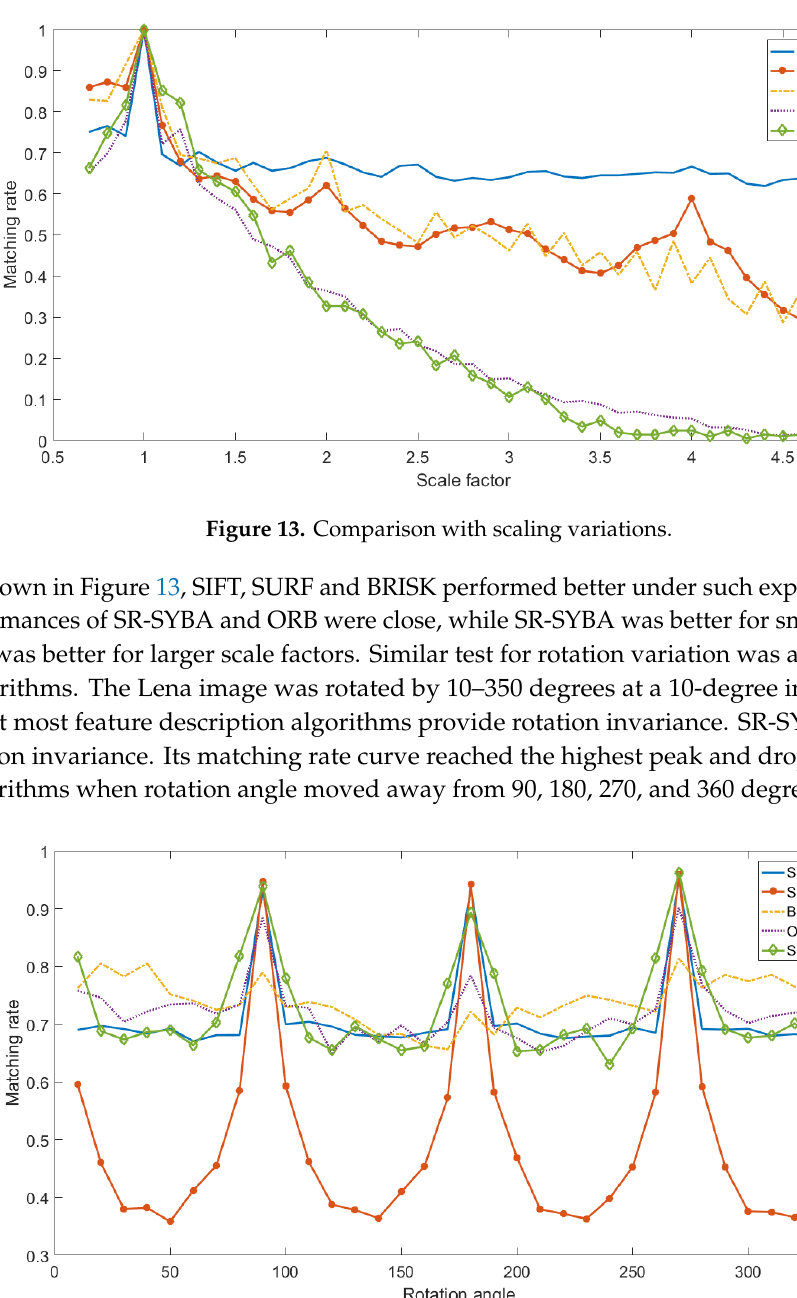
Figure 14. Comparison with rotation variations.